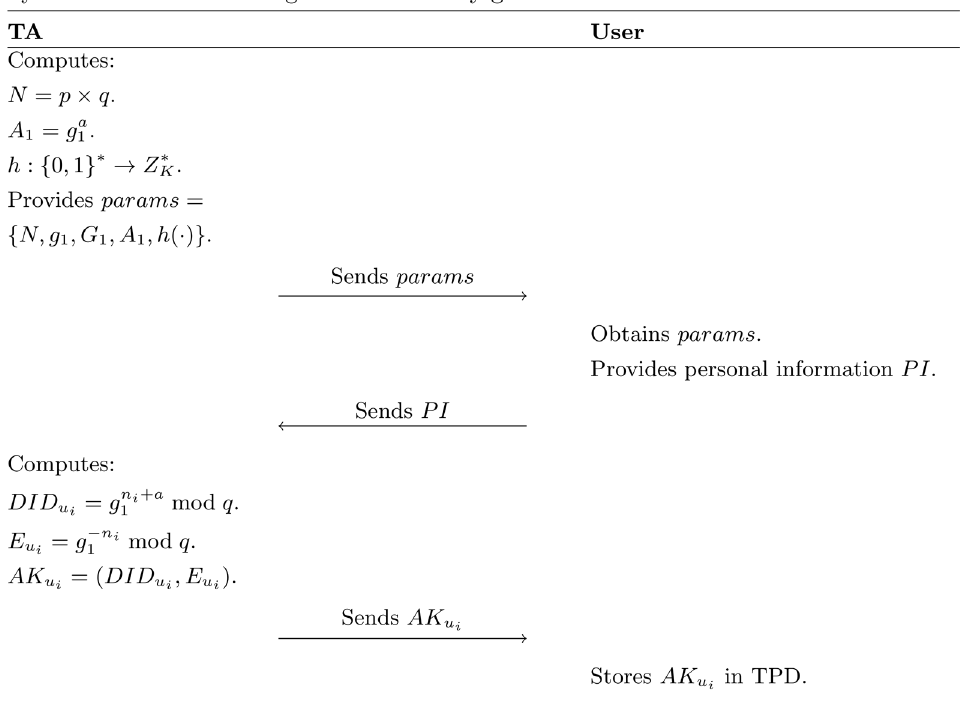
Fig 3. System initialization—Registration and key generation phase in [28].